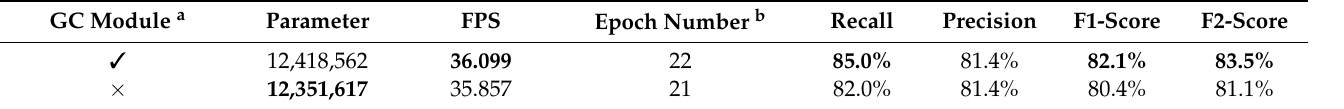
Table 4. Ablation experiments on the Global Context (GC) module a